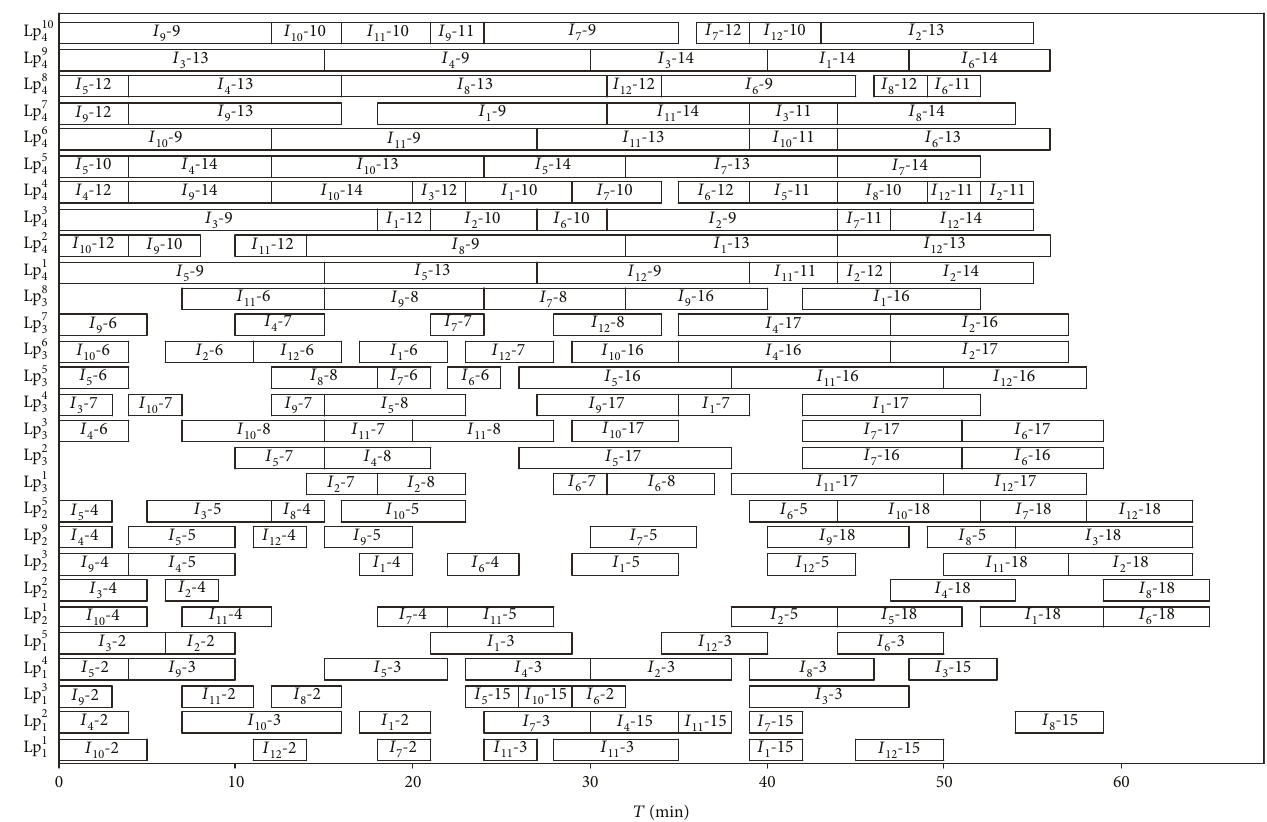
Figure 8: Gantt chart of optimal personnel allocation in deterministic mission case